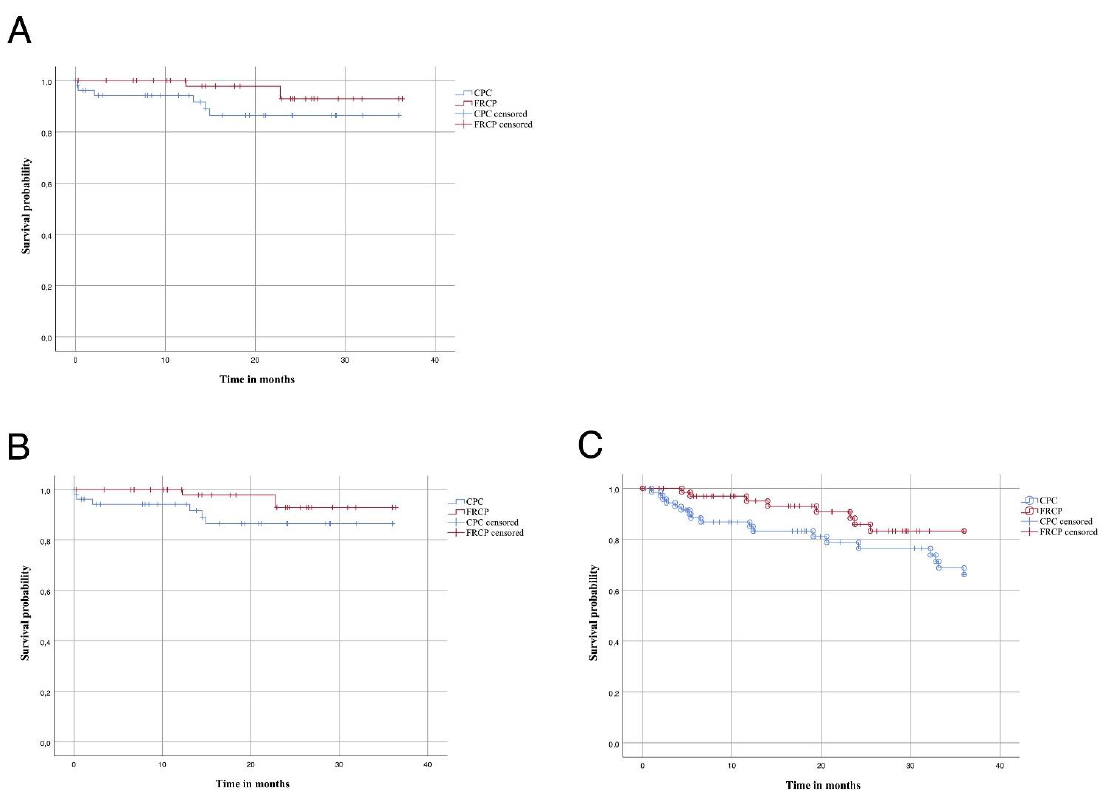
Figure 1. ( A ) Survival probabilities of the cast post-and-core (CPC) and the fiber-reinforced composite resin posts (FRCP), including all censored teeth after 60 months of observation. Kaplan–Meier plots of CPC and FRCP are shown. ( B ) CPC or FRCP treated single crowns and ( C ) telescopic dentures up to 36 months are shown.